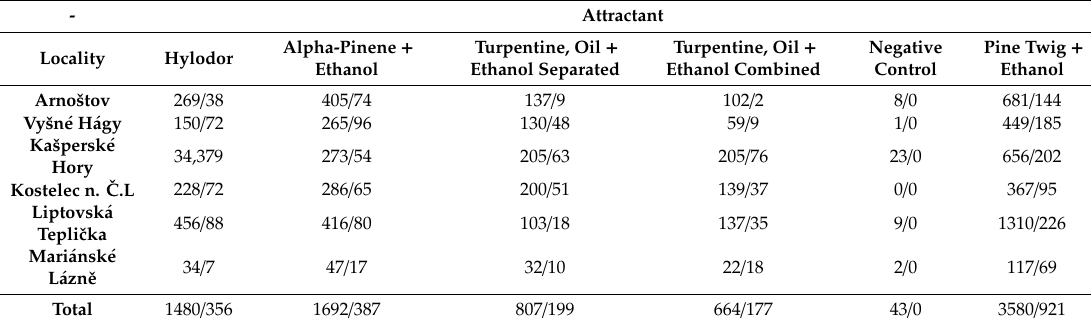
Table 3. Numbers of H. abietis / H. pinastri trapped as a ff ected by locality and